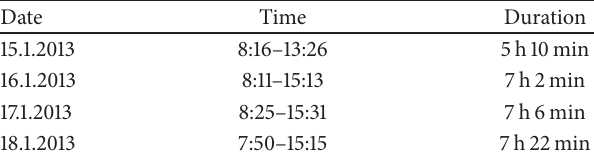
Figure 3: Schematic for cable arrangement. Table 2: Date, time, and duration of asphalt heating experiment.